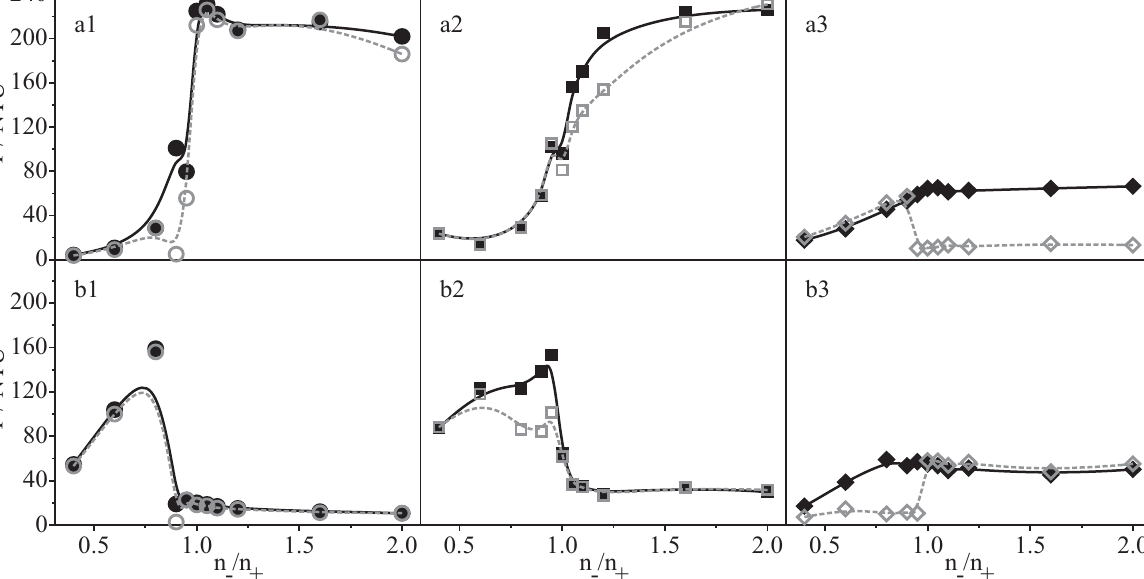
/n ratio and on time. − +